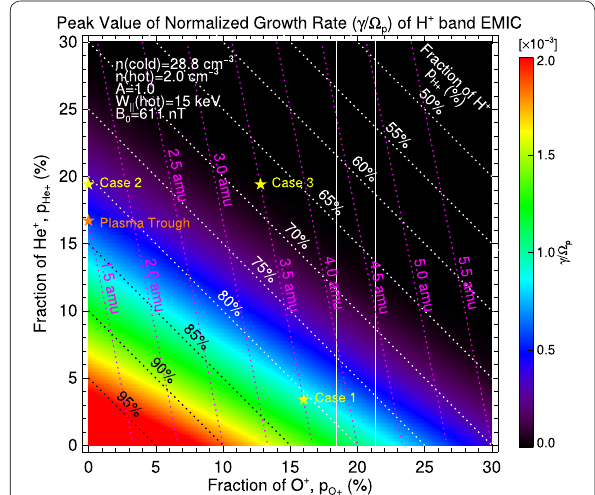
Fig. 8 Peak values of γ/ ω p as a function of p He + and p O + , using the same parameters as Fig. 7 except for the ion composition. Color scale indicates γ/ ω p . White and black dotted lines delineate p H + from 50% to 95% at 5% intervals. Magenta dotted lines show M from 1.5 amu to 5.5 amu at 0.5 amu intervals. Yellow stars indicate the peak values of γ/ ω p for cases 1–3 (Fig. 7b, d, and f), while an orange star shows a value for the plasma trough that consists of H + and He + ions and has M 1.5 amu =